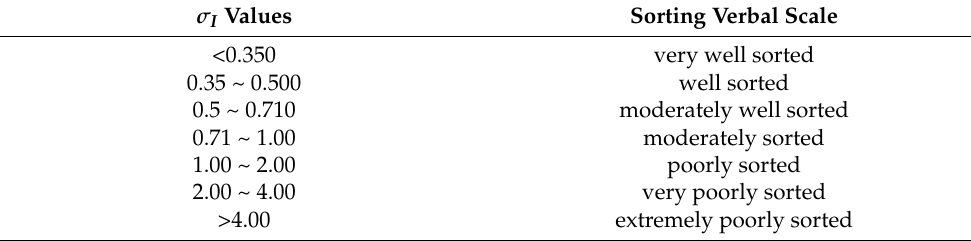
Table 1. Classification scale for sorting.